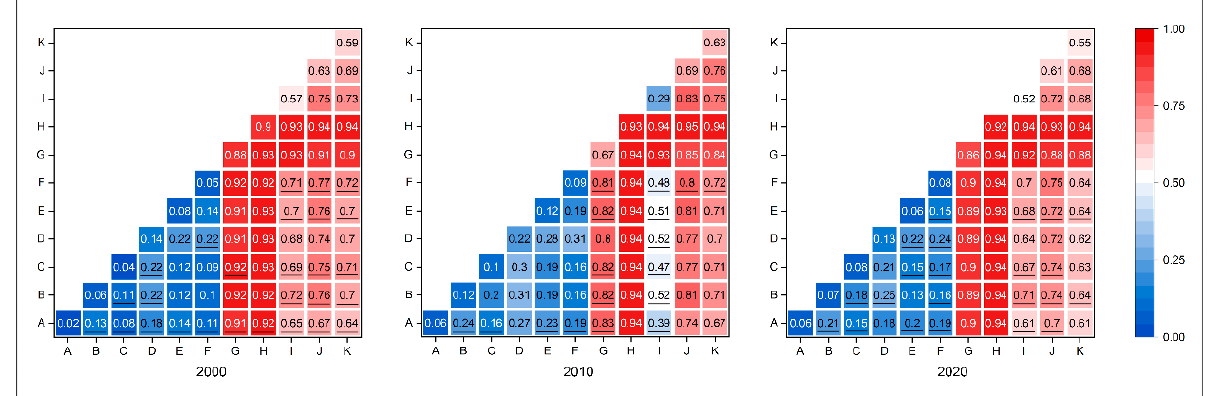
Figure 12. Results of the landscape-level interaction detector (A: PD; B: LPI; C: ED; D: FRAC_AM; E: CONTAG; F: SHDI; G: FVC; H: NDBI; I: MNDWI; J: nigh tt ime light; K: population density.).